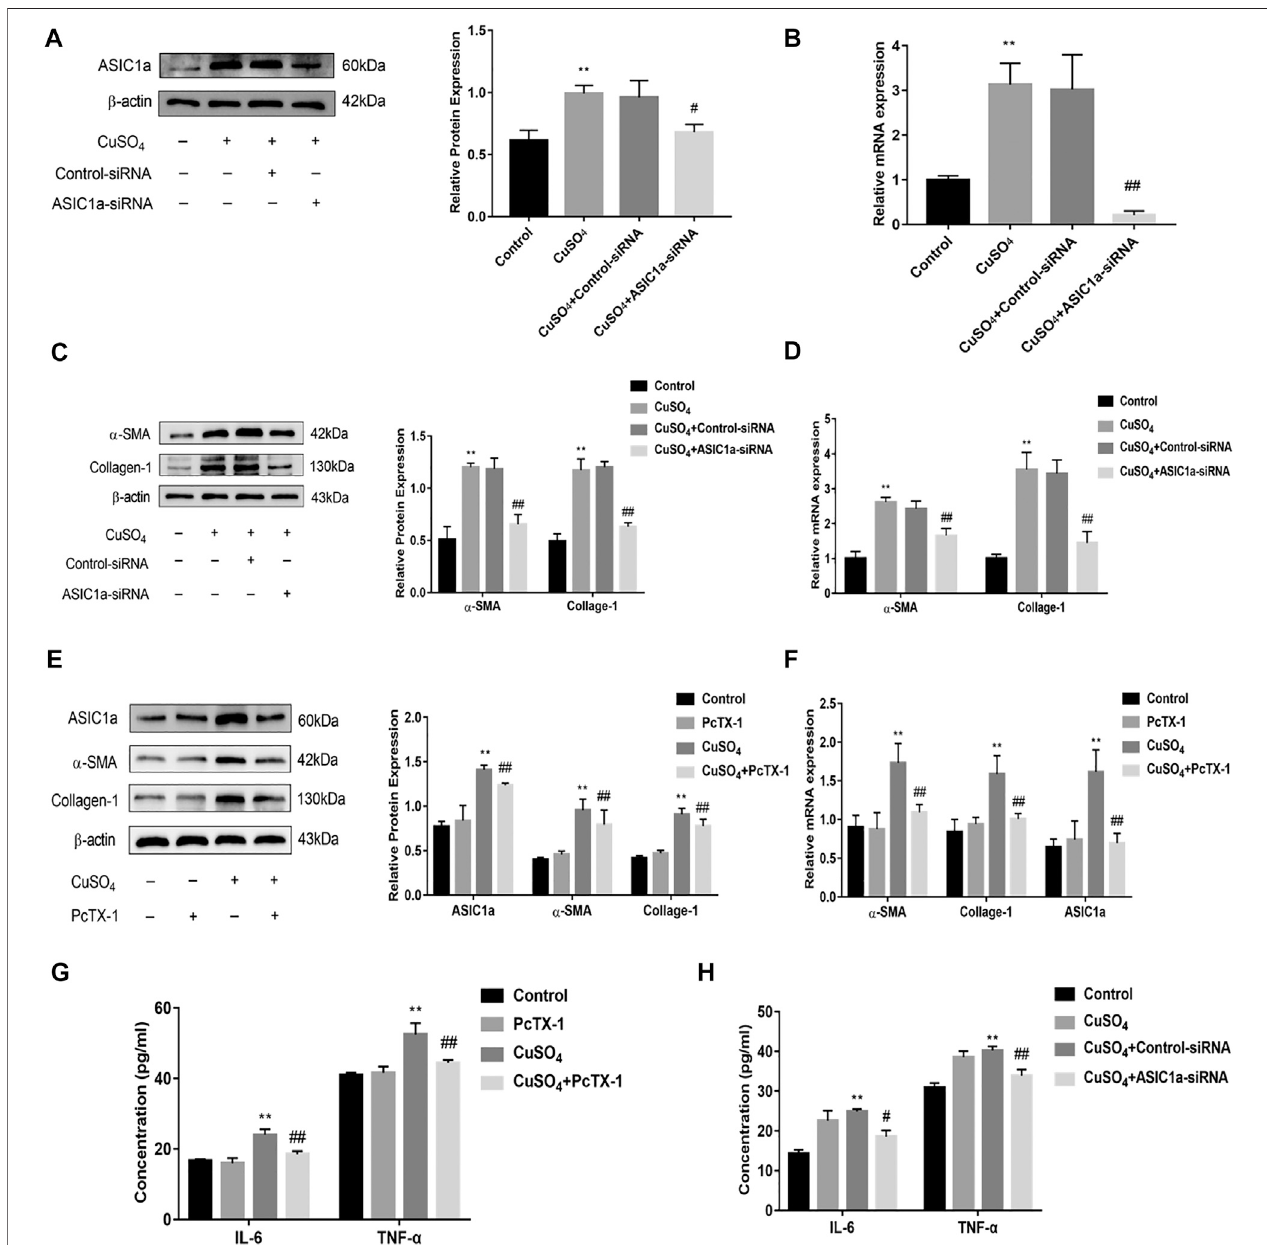
FIGURE 2 | Effect of ASIC1a-siRNA transfection and PcTX-1 on ASIC1a, α -SMA, and collagen- Ι expression in HSC-T6 cells (A) Western blotting analysis and densitometricquanti fi cationofASIC1aproteinlevelsinHSCsaftertransfectionofASIC1a-siRNA; (B) mRNAlevelsofASIC1ainHSCsaftertransfectionofASIC1a-siRNA (C) Expressionofthe fi broticproteinsinHSCsaftertransfectionofASIC1a-siRNA; (D) mRNAlevelsof α -SMAandCollagen-IinHSCsaftertransfectionofASIC1a-siRNA (E) Western blotting analysis and densitometric quanti fi cation of α -SMA, and Collagen-I protein levels in HSCs under PcTX-1; (F) mRNA levels of α -SMA, and Collagen-I in HSCs treated with PcTX-1 (G) Levels of IL-6 and TNF- α in cell medium after treatment with PcTX-1; (H) Levels of IL-6 and TNF- α in the cell medium after transfectionwithASIC1A-siRNA.Statisticalanalyseswereperformedusingt-test.Dataareexpressedasthemean ± SEM( n (cid:2) 4).* p < 0.05,** p < 0.01vs.Controlgroup; # p < 0.05, ## p < 0.01 vs. CuSO 4